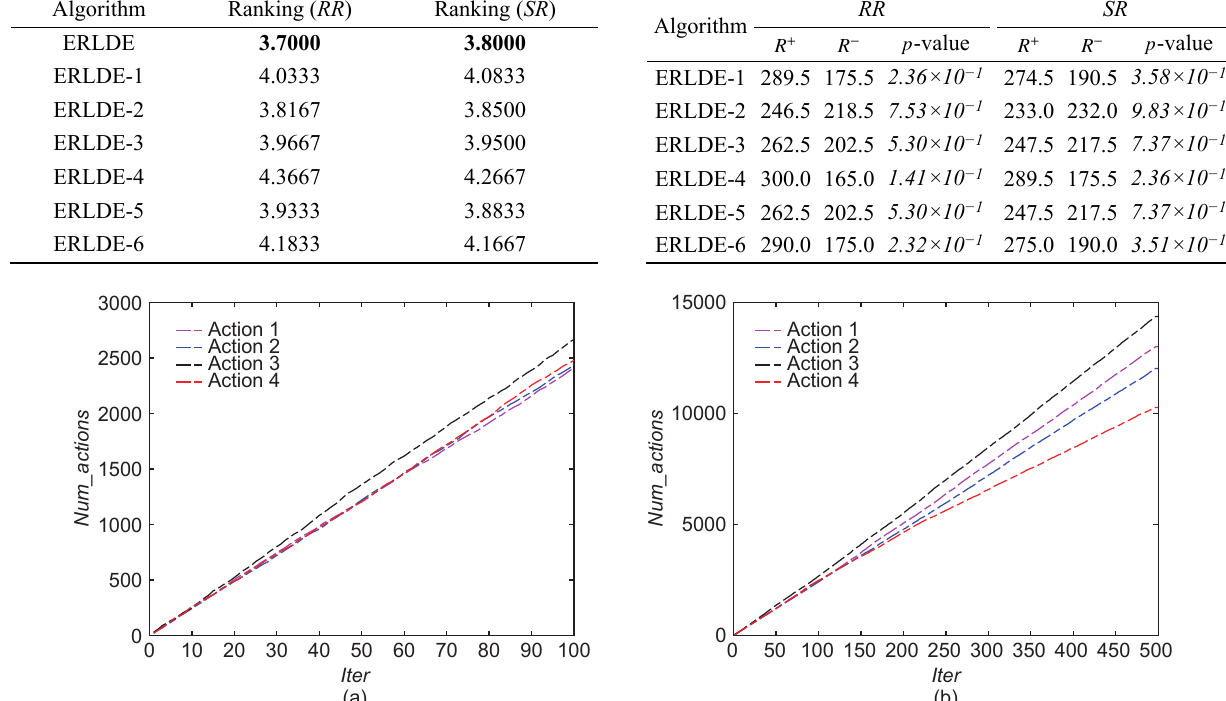
Fig. 3 Comparison of the used number of different